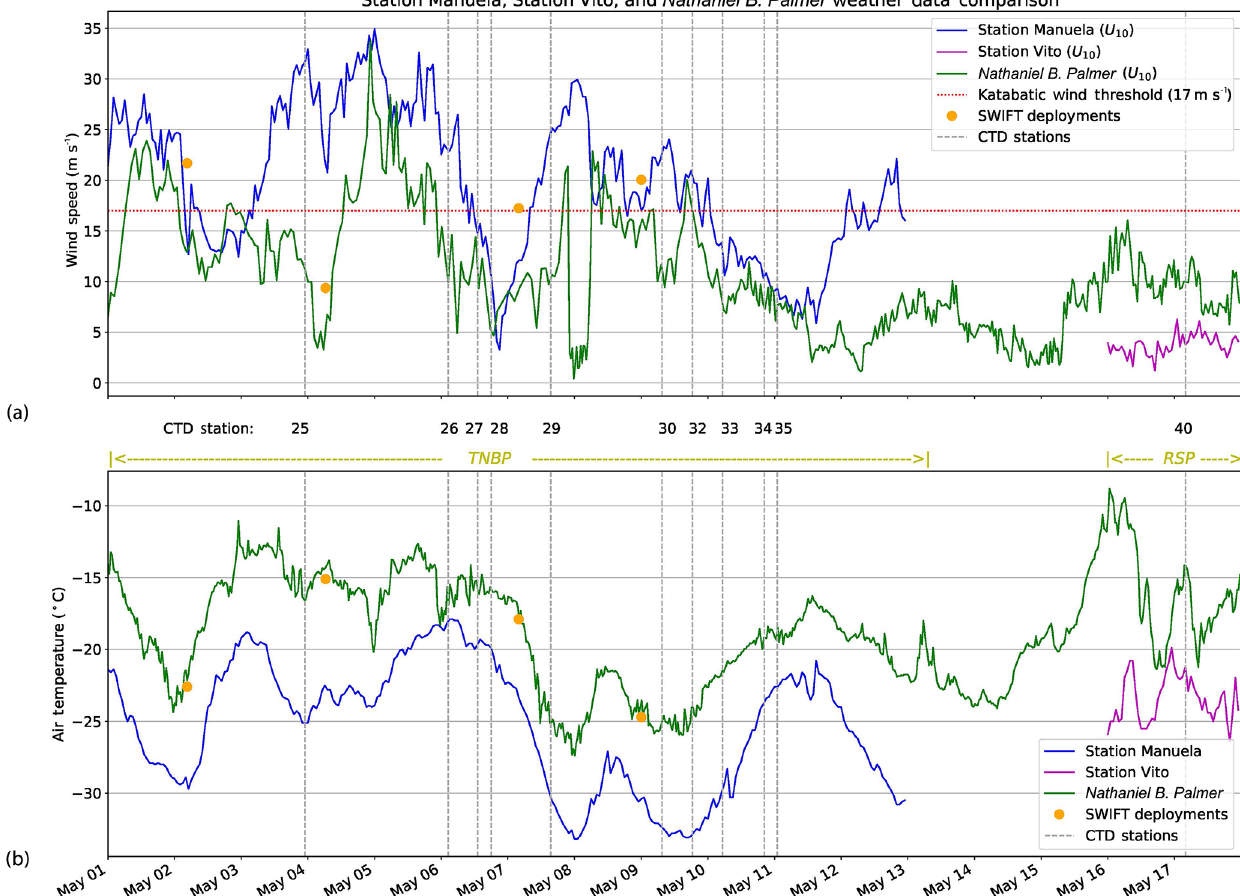
Figure 3. Weather observations from 1 to 17 May 2017. (a) Wind speed from Station Manuela (blue line), Station Vito (purple line), RVIB Nathaniel B. Palmer (green line), and SWIFT (orange marker) deployments adjusted to 10m. The commonly used katabatic threshold of 17ms − 1 is depicted as a “dotted red line”, as well as the date and start time of each CTD cast. (b) Air temperature from Station Manuela, Station Vito, RVIB Nathaniel B. Palmer , and SWIFT